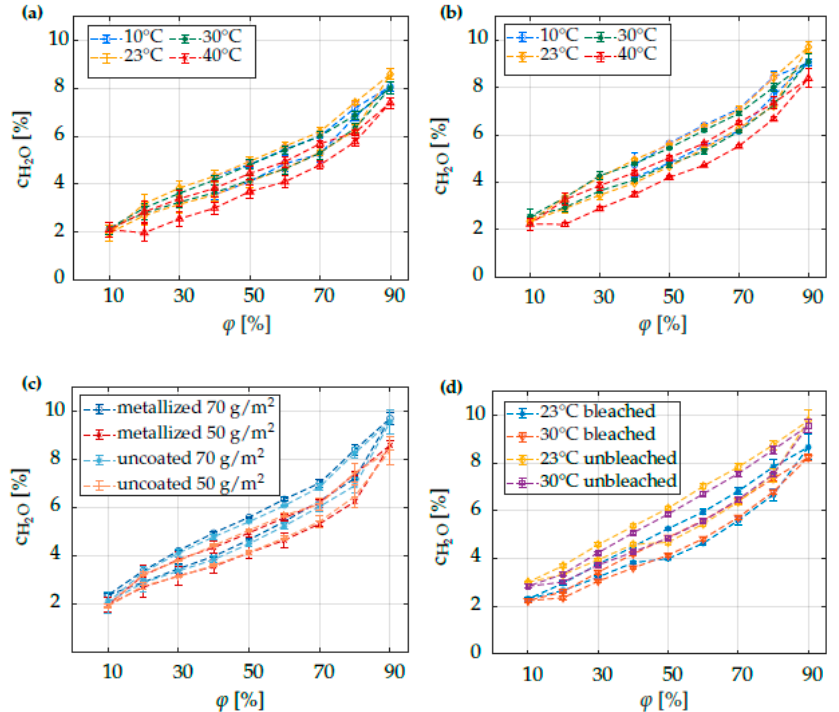
Figure 2. Sorption isotherms of 50 g/m2 ( a ) and 70 g/m2 ( b ) metalized paper at different temperatures, the metalized paper compared to the uncoated paper ( c ) and the bleached compared to the unbleached Kraft paper at 23 °C and 30 °C ( d ).